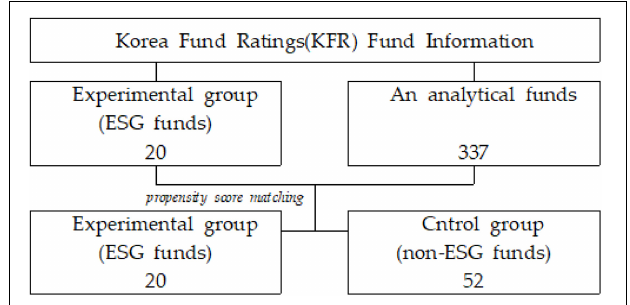
FIGURE 2 | The sampling